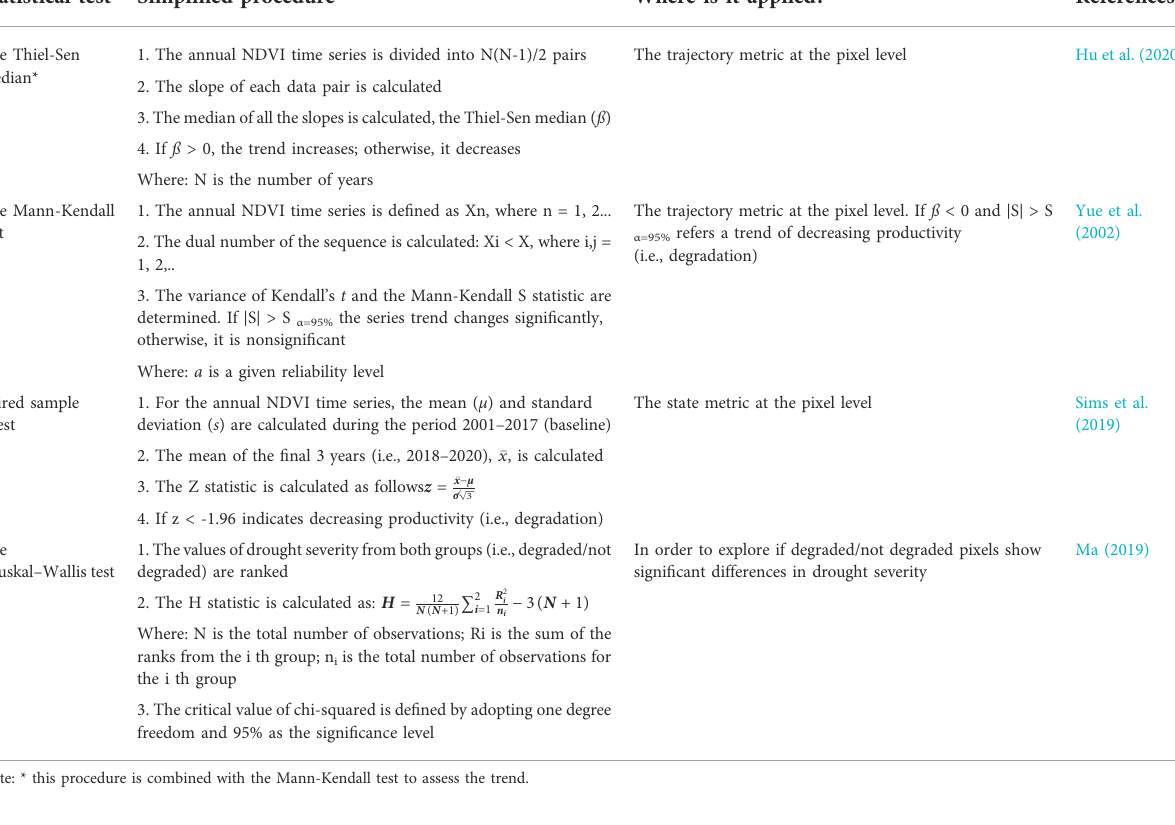
TABLE 1 List of statistical tests applied in this study.